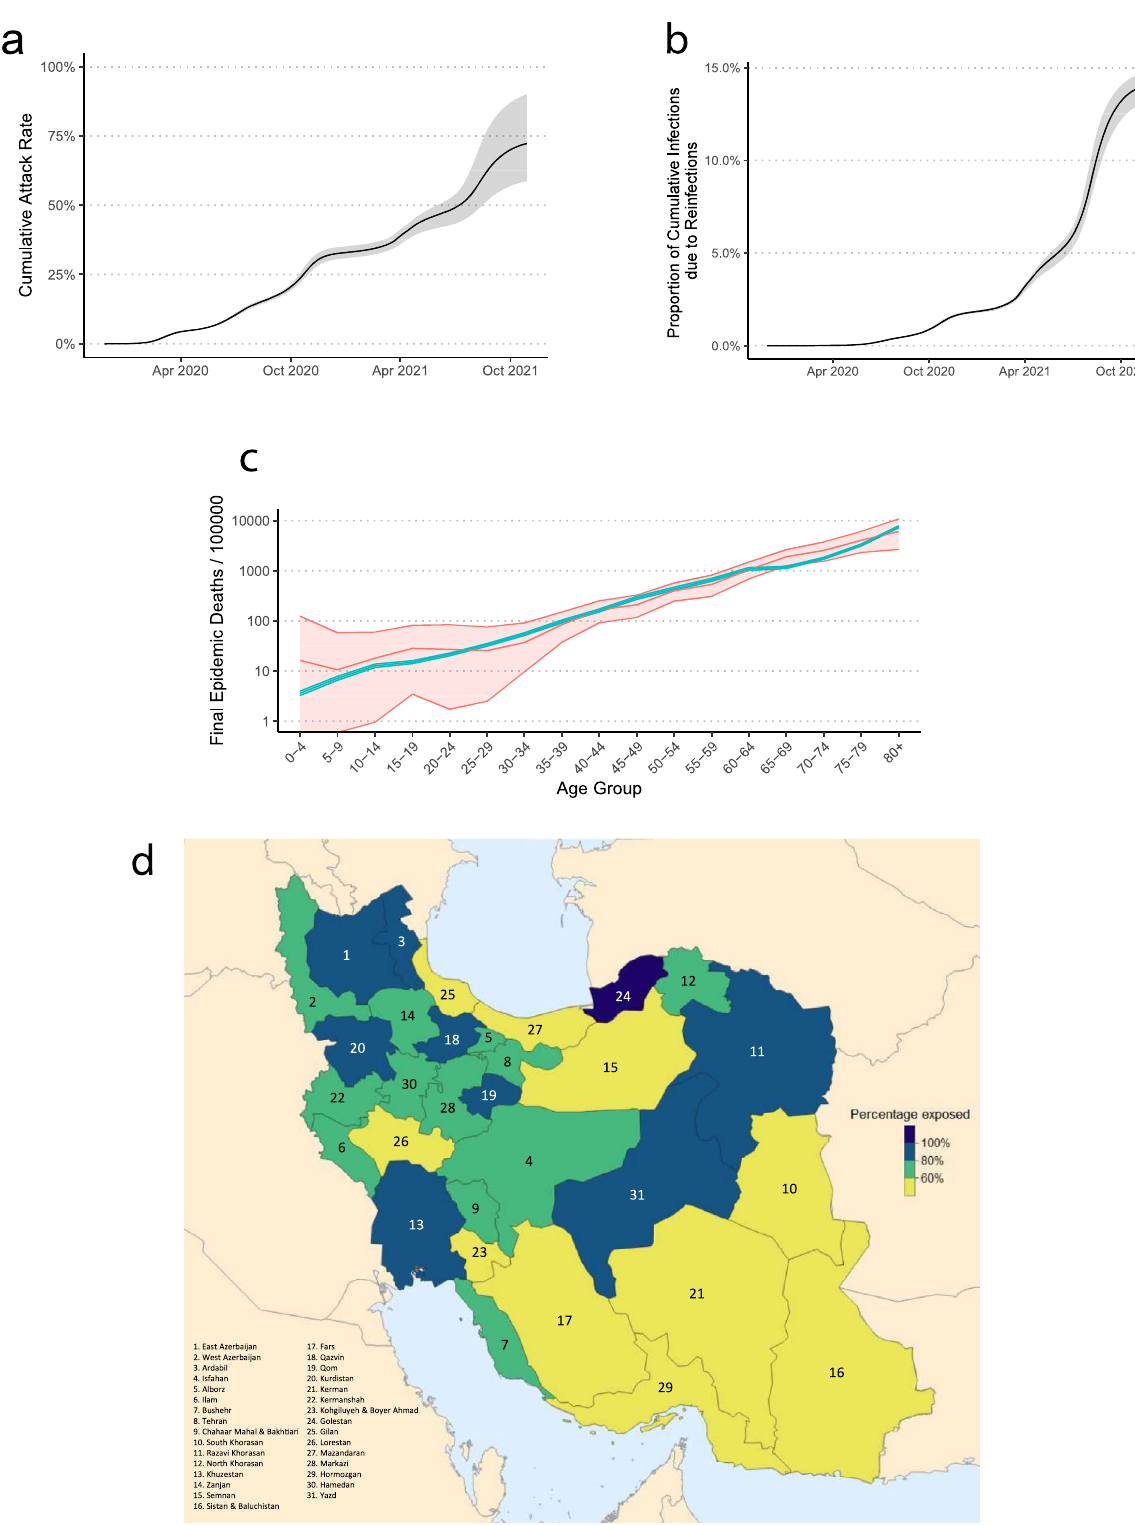
Fig. 2 Estimating cumulative attack rates and reinfection rates of SARS-CoV-2 in Iran. a Modelled cumulative nationwide attack rate of SARS-CoV-2 and b percentage of individuals reinfected over time. In both a and b, shaded area in black shows the estimated quantities from the three sets of model assumptions used for estimating attack rates. The central line shows the central scenario and bands show the range re fl ected by the optimistic and worst- case scenarios. c Per-capita excess mortality per age-group according to the transmission model (green) and observed data (red). The green line shows the model output for the median excess mortality according to the central model fi t and the shaded area shows the 95% con fi dence intervals for the model estimate. The red line shows the excess mortality estimates based on the linear regression model with central line and shaded area representing the median and 95% forecast intervals for weekly excess mortality. d Cumulative attack rate of SARS-CoV-2 per province as of